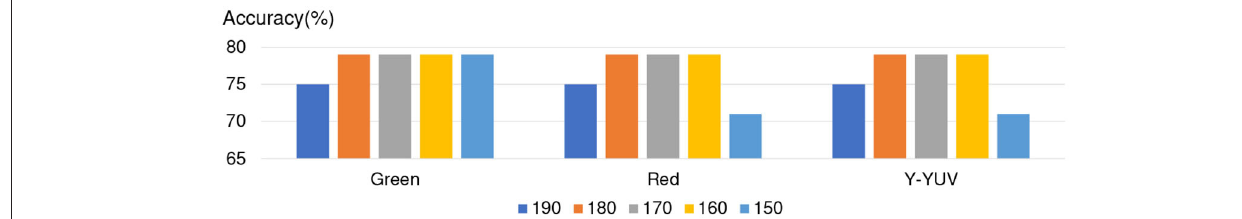
FIGURE 7 | Channels discussion about NN.